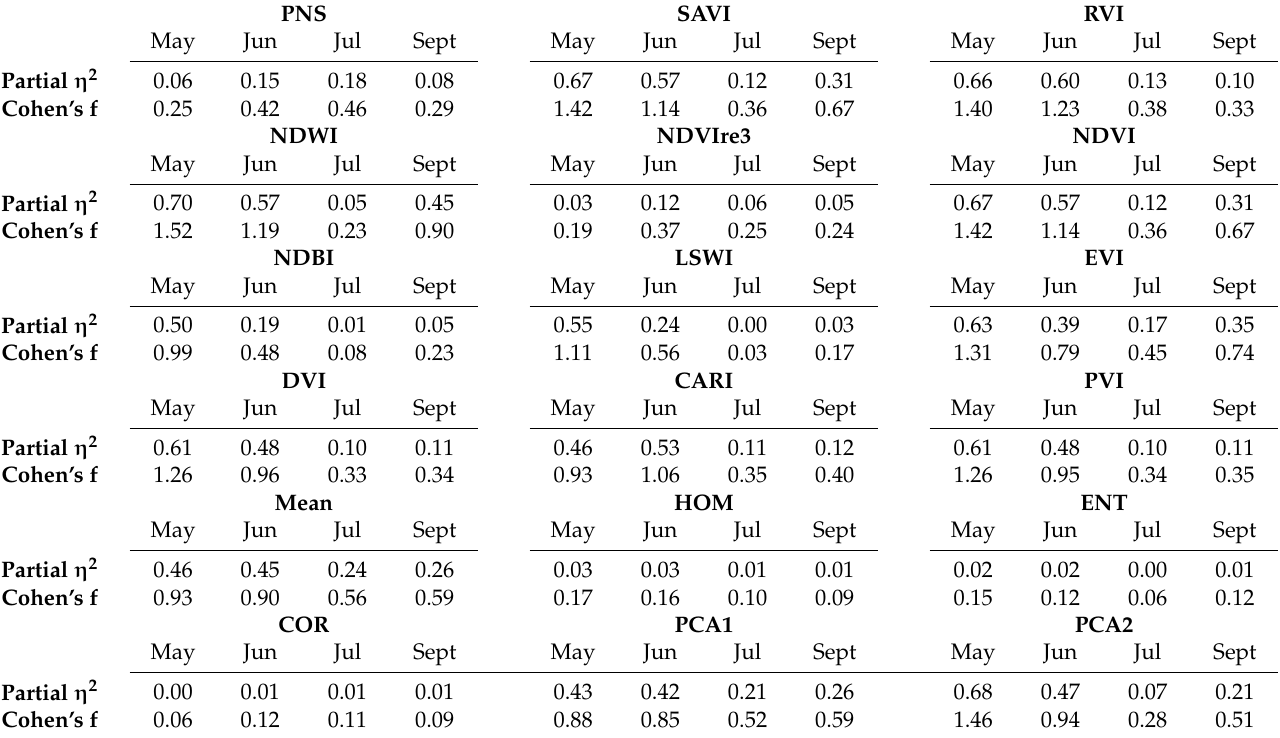
Table 4. Quantitative results of vegetation separability under different period